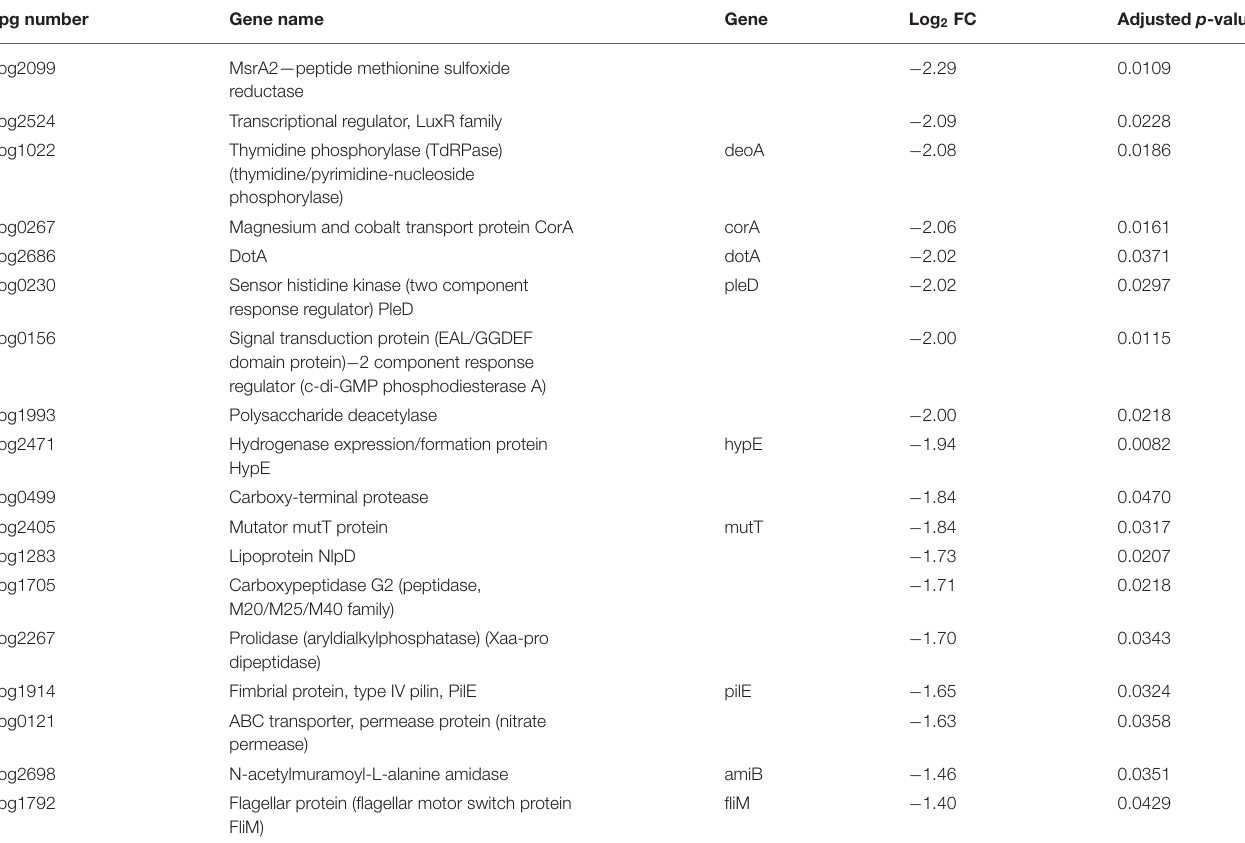
TABLE 3 | Selected downregulated genes identified by